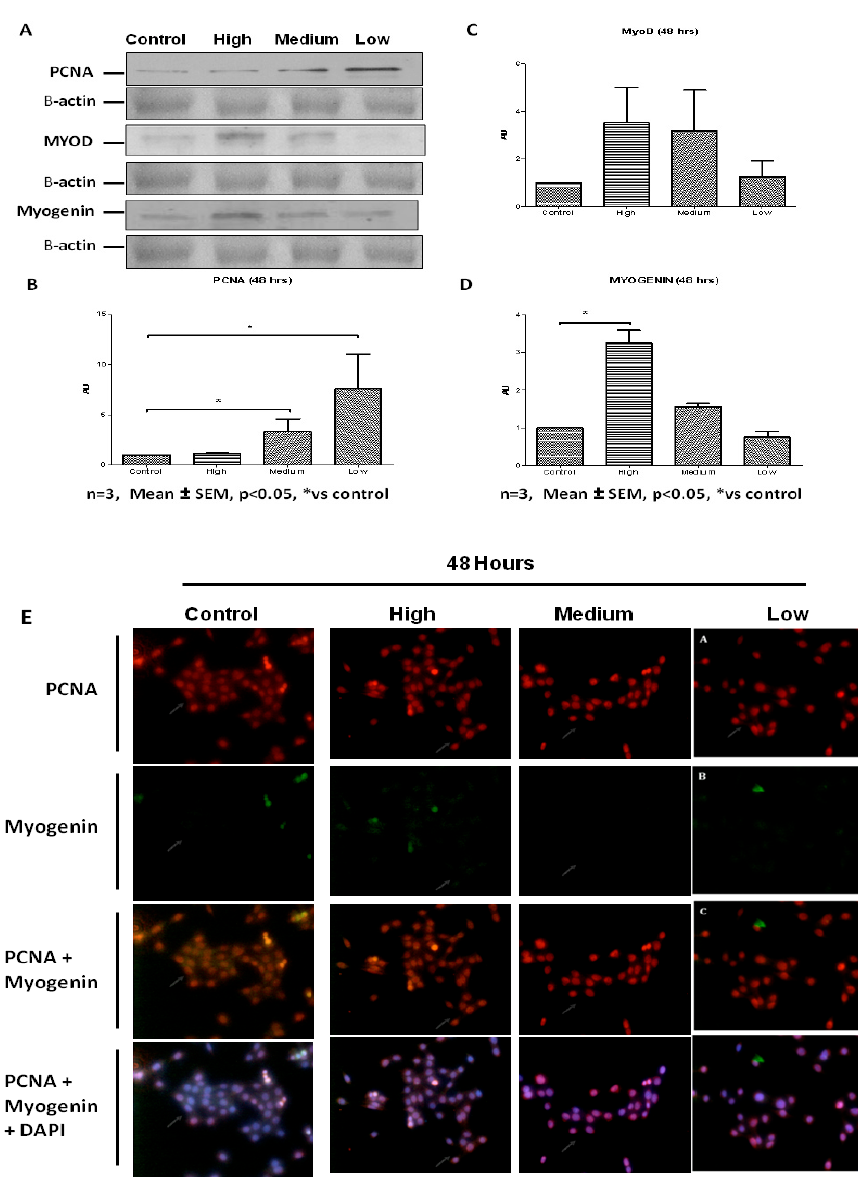
Figure 4. Concentration-dependent effect of IL-6 on C2C12 myogenic regulatory factors’ protein levels. ( A ) Evaluation of PCNA, MyoD and myogenin protein levels in C2C12 cells treated with low, medium and high IL-6 concentrations for 48 h. ( B ) Quantification of PCNA protein levels as shown in ( A ). ( C ) Quantification of MyoD protein levels as shown in ( A ). ( D ) Quantification of myogenin protein levels as shown in ( A ). ( E ) Immunofluorescence staining for PCNA and myogenin in C2C12 cells after treatment with low, medium and high IL-6 concentrations for 48 h. The experiment was repeated three times. Immunofluorescence images were taken at 100× magnification. Results are presented as mean ± standard error of the mean (S.E.M). Statistical analysis: ANOVA and Bonferroni post hoc test. * p < 0.05. TorevealmechanisticpathwaysthroughwhichIL-6mightaffectC2C12characteristics, theactivation of the JAK-STAT pathway in IL-6-treated cells was examined. The activation of JAK-STAT